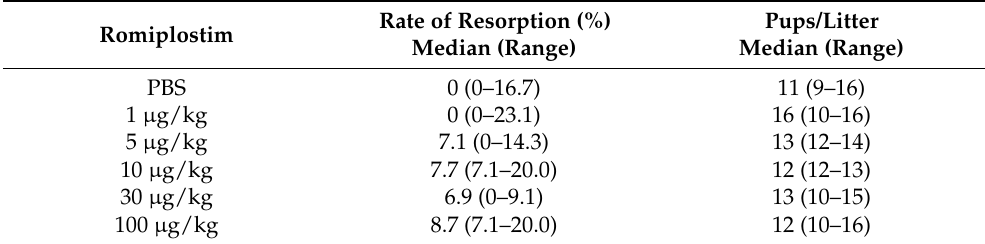
Figure 5. Placental weight, the spiral arteries of basal decidua, and RNA expression of VEGF signaling in placentas on GD18. ( A ) There was no significant difference in placental weight in the romiplostim treated group compared to the control group. Bars represent the median. Error bars represent range. ( B ) The thickness of the arterial wall of the spiral artery was calculated as: ((a) outer diameter-(b) inner diameter)/2. Scale bars 50 µm, 20 magnification. ( C ) There was no significant difference in the thickness of the arterial wall of the spiral artery in the romiplostim treated group compared to the control group. Bars represent the median. Error bars represent range. ( D ) There was no significant difference in the mRNA expression levels of sFLT1, PlGF, VEGF-A, and VEGF-B by quantitative PCR in the placenta of pregnant mice treated with romiplostim compared to the control group. Bars represent the mean. Error bars represent standard deviation. Table 1. The rate of resorption and the number of pups per litter when romiplostim was administered to pregnant